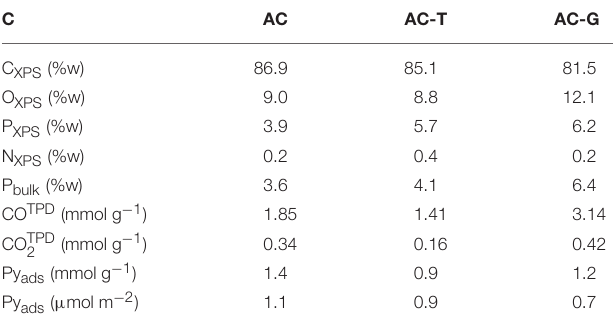
TABLE 2 | Surface chemistry of the activated